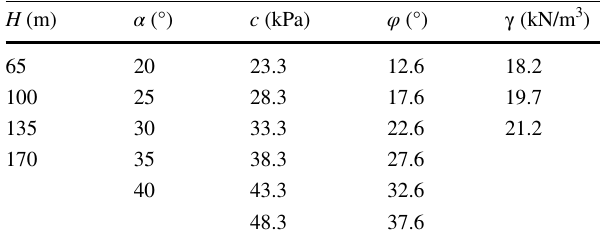
Table 1 Values setting rule of control factors